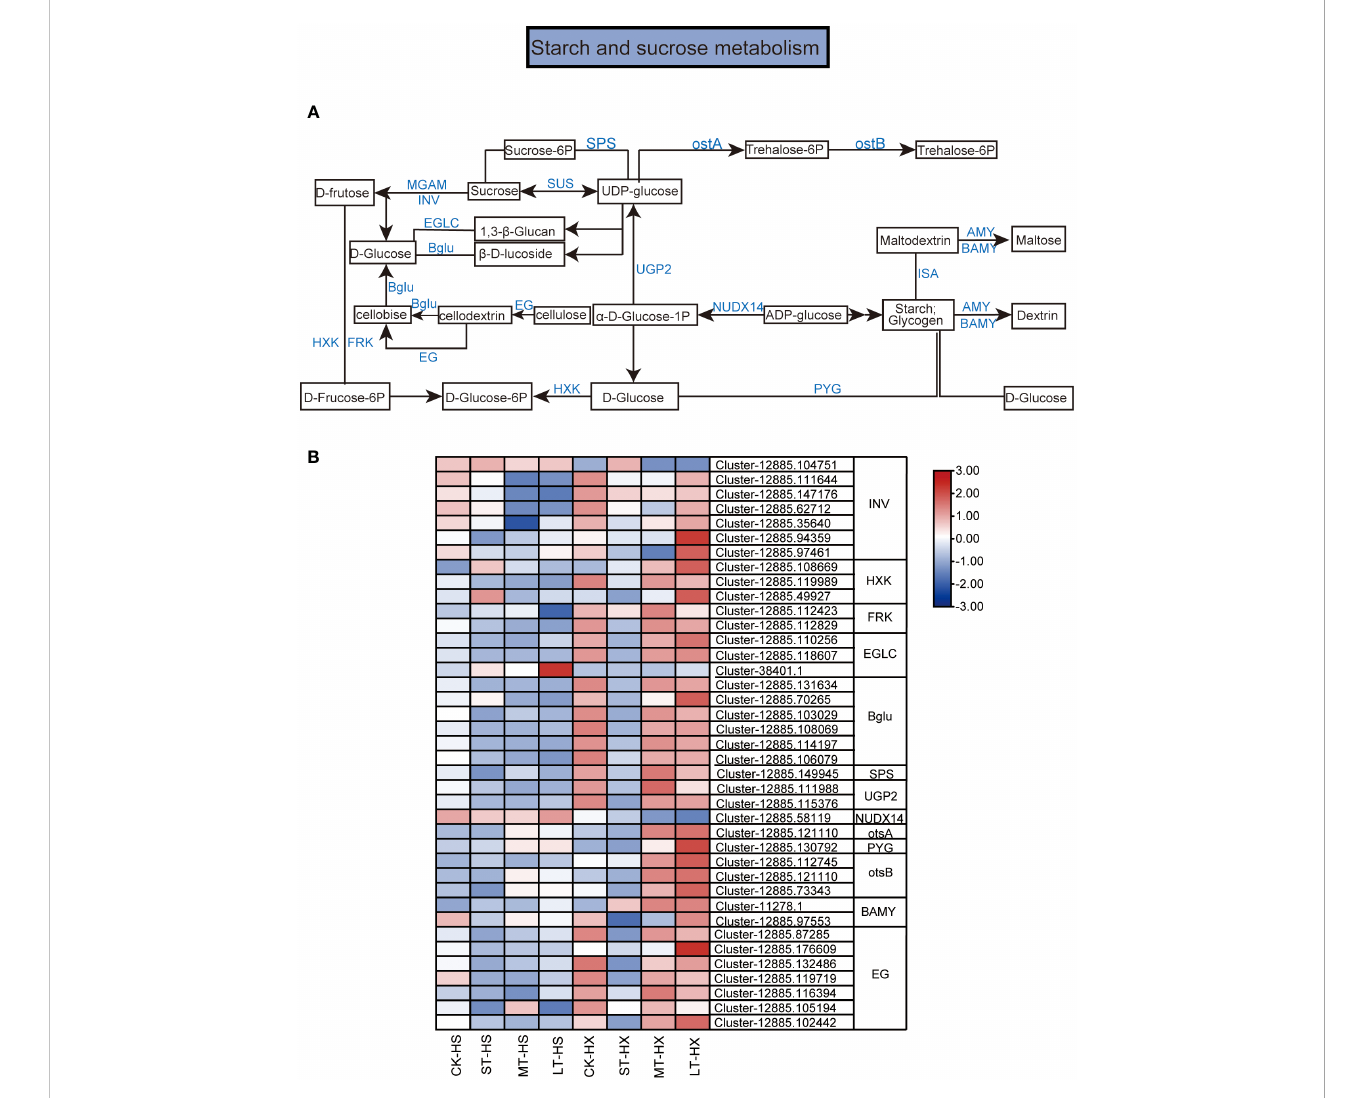
FIGURE 7 KEGG pathway annotation diagram for the starch and sucrose metabolism pathway of DEGs. (A) Schematic diagram of the KEGG pathway for the enrichment of DEGs in the starch and sucrose metabolism pathway. Blue text indicates enzymes and black text indicates metabolites. (B) Heatmap showing the expression of DEGs. Box color indicates the expression level of each gene: blue = decreased expression and red = increased